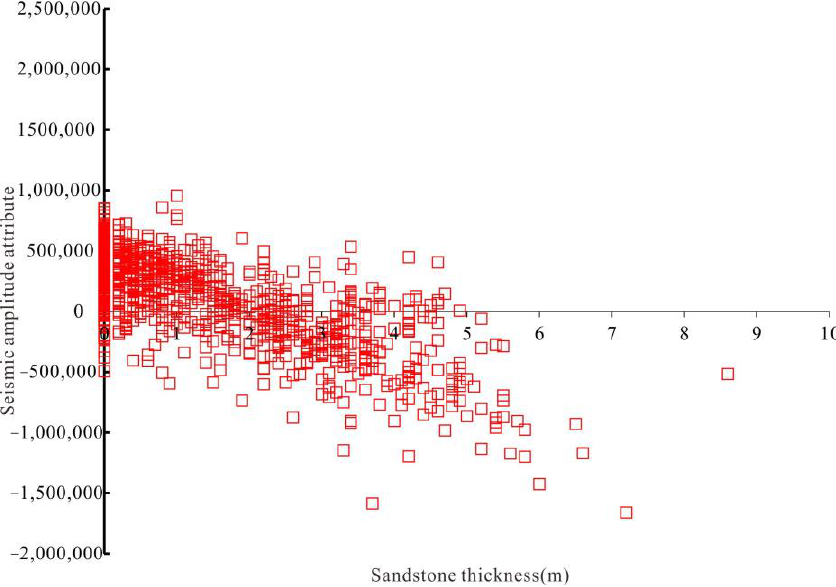
Figure 6. Relationship between the dominant amplitude and sandstone thickness in layer G I 2